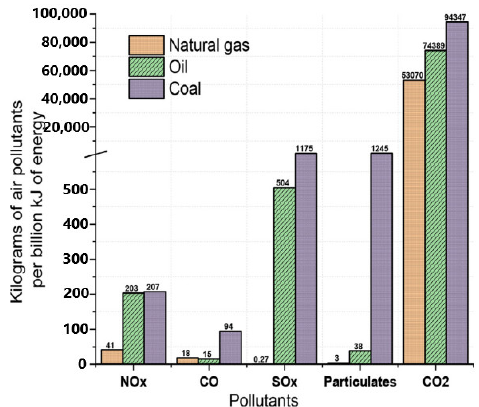
Figure 1. Air pollutant emissions analysis for natural gas compared with coal and oil [3]. Reproduced with permission from Energy